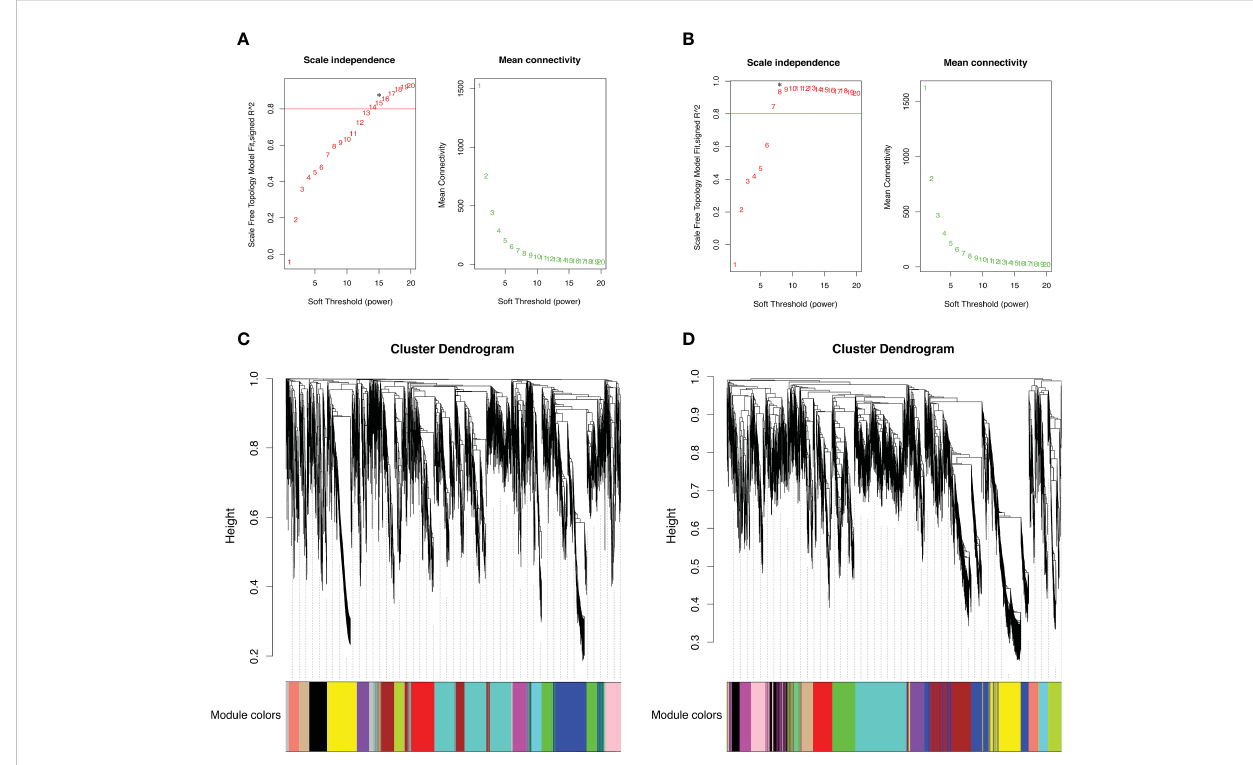
FIGURE 3 Plot of scale free topology and mean connectivity in regard to soft-thresholding power and Clustering dendrogram showing ortholog expression pattern for samples from (A, C) late fl ower bud and (B, D) early leaf buds. Red line indicates an R 2 cut-off of 0.8. Asterisk indicates the soft threshold power chosen for module detection. Each colored bar below represents each